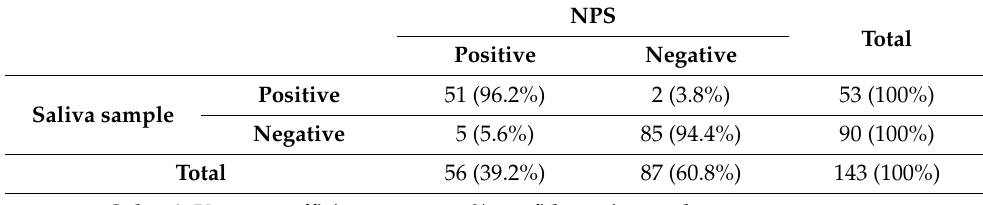
Table 2. Virological results for 143 samples (saliva and NPS) analyzed for SARS-CoV-2 and other respiratory pathogens. Virological Results N = 143 Detection in NPS SARS-CoV-2 56 (39.0%) Detection in saliva sample Positive for at least one respiratory virus 90 (63.0%) Positive for at least one respiratory virus other than SARS-CoV-2